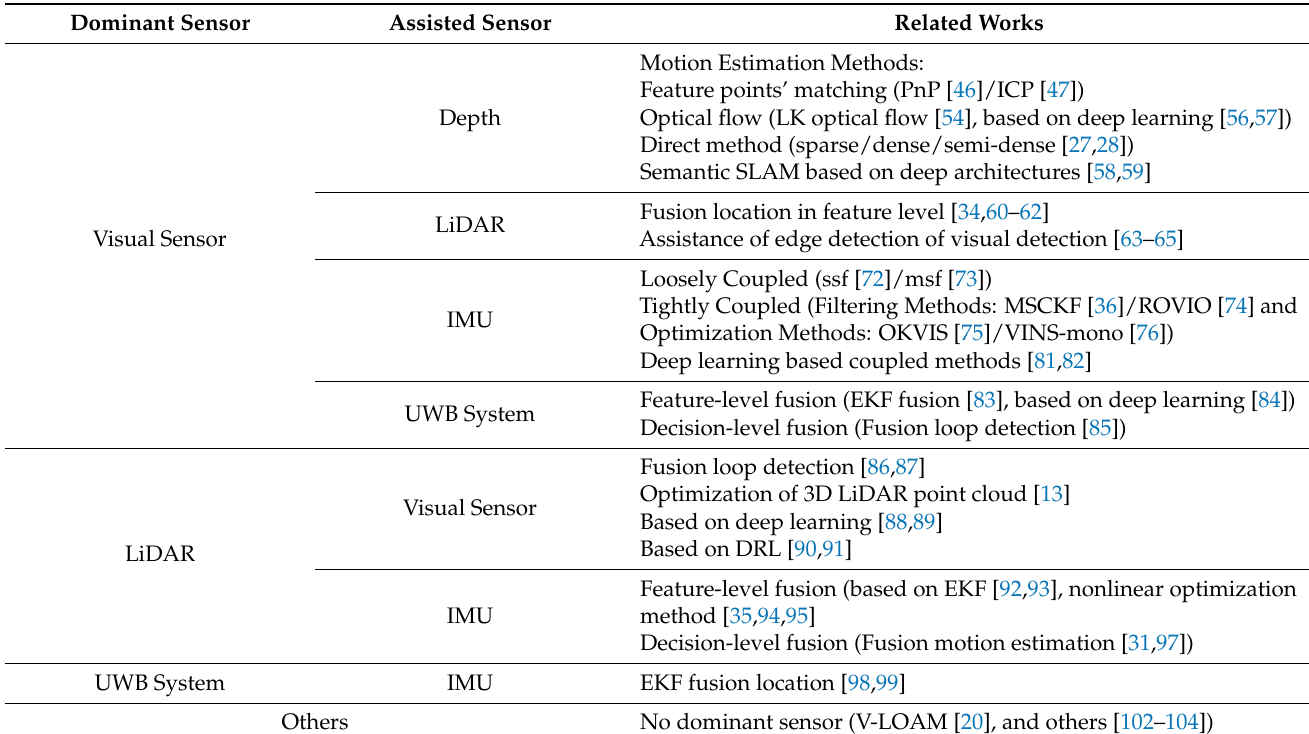
Table 2. Summary of multi-sensor fusion navigation